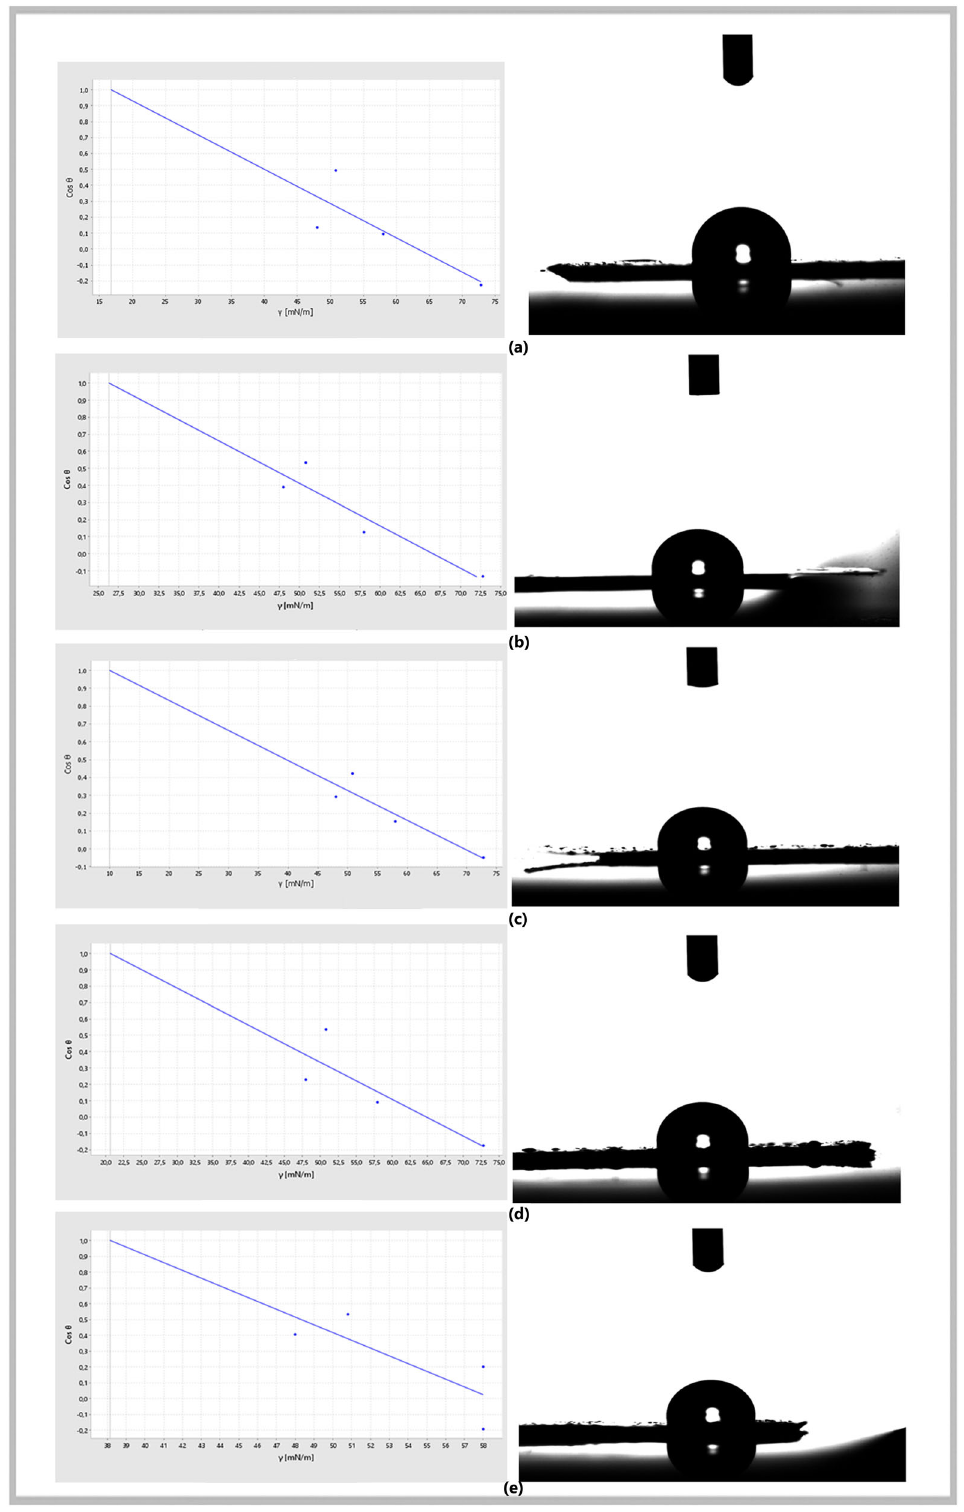
Fig. 4 Zisman plot and water drop on the surface of the samples. a Pure polypropylene Zisman plot and water drop on the surface. b 0.5% fumed silica-doped polypropylene Zisman plot, and water drop on the surface. c 1% fumed silica-doped polypropylene Zisman plot and water drop on the surface. d 1.5% fumed silica-doped polypropylene Zisman plot and water drop on the surface. e 2% fumed silica-doped polypropylene Zisman plot and water drop on the surface. The water ’ s contact angle with the fog harvesting materials is measured as 103° for pure polypropylene, 97° for 0.5% fumed silica-doped PP, 92° for 1% fumed silica-doped PP, 100° for 1.5% fumed silica-doped PP, and 102° for 2% fumed silica-doped PP. Cos θ is drop angel on the surface and γ is surface tension of the test